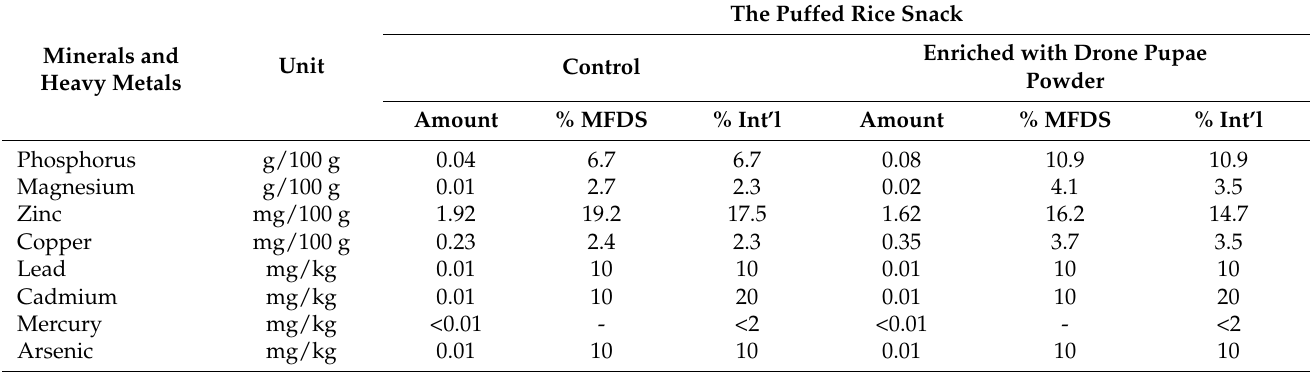
Table 16. The mineral and heavy-metal composition of the control and drone-pupae-powder enriched puffed-rice